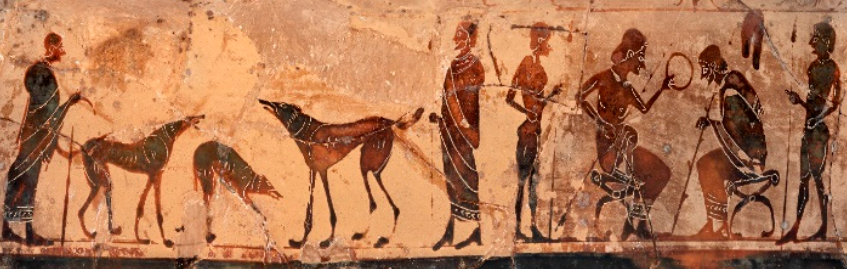
Figure 10. Detail of Figure 9.